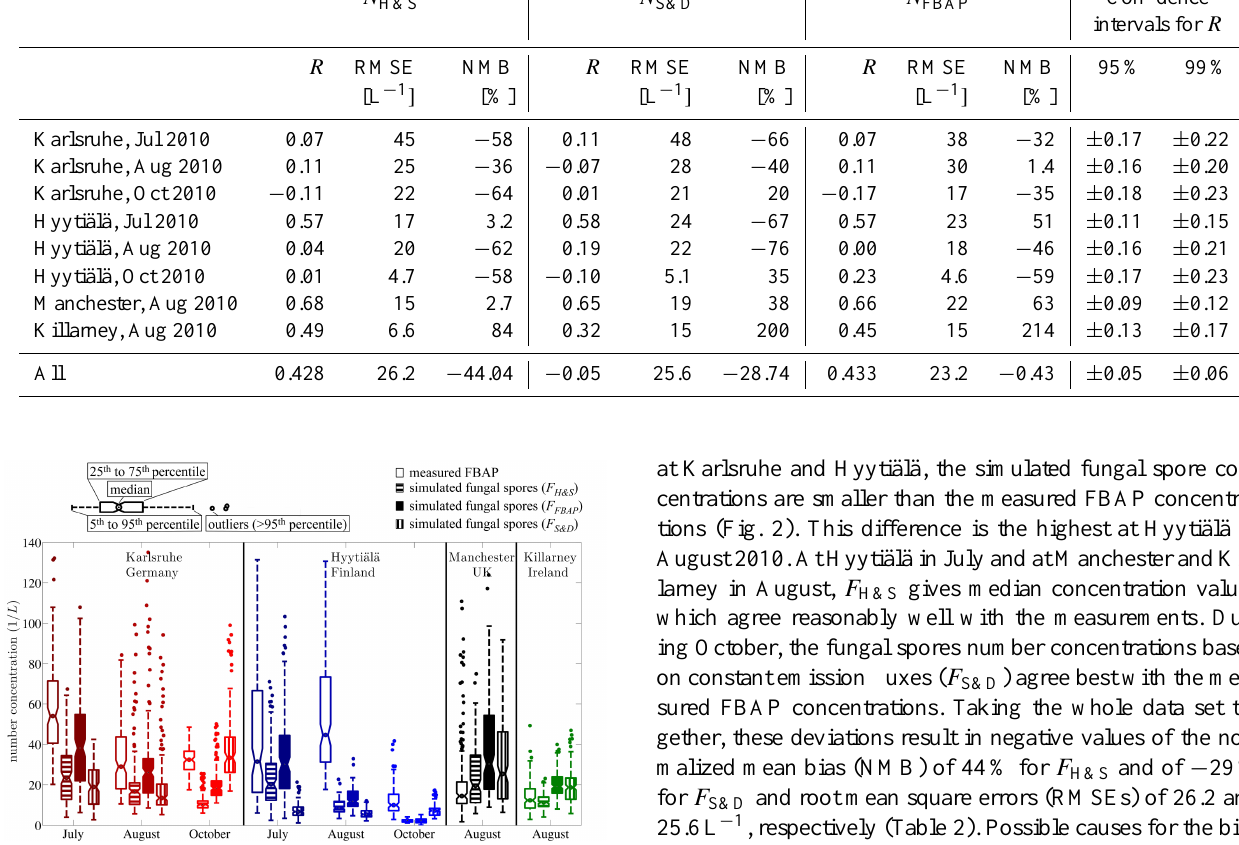
Figure 2. Box-whisker plots for all case studies of measured hourly FBAP concentration (open boxes), simulated fungal spore concen- tration with three different emission parameterizations: F H&S from Heald and Spracklen (2009; horizontally hatched boxes), F FBAP from this study (filled boxes), and F S&D from Sesartic and Dal- lafior (2011; vertically hatched boxes). The central mark of each box shows the median, its edges the 25th and 75th percentiles, and whiskers show 5th and 95th percentiles. Dots above whisker show outliers (>95th